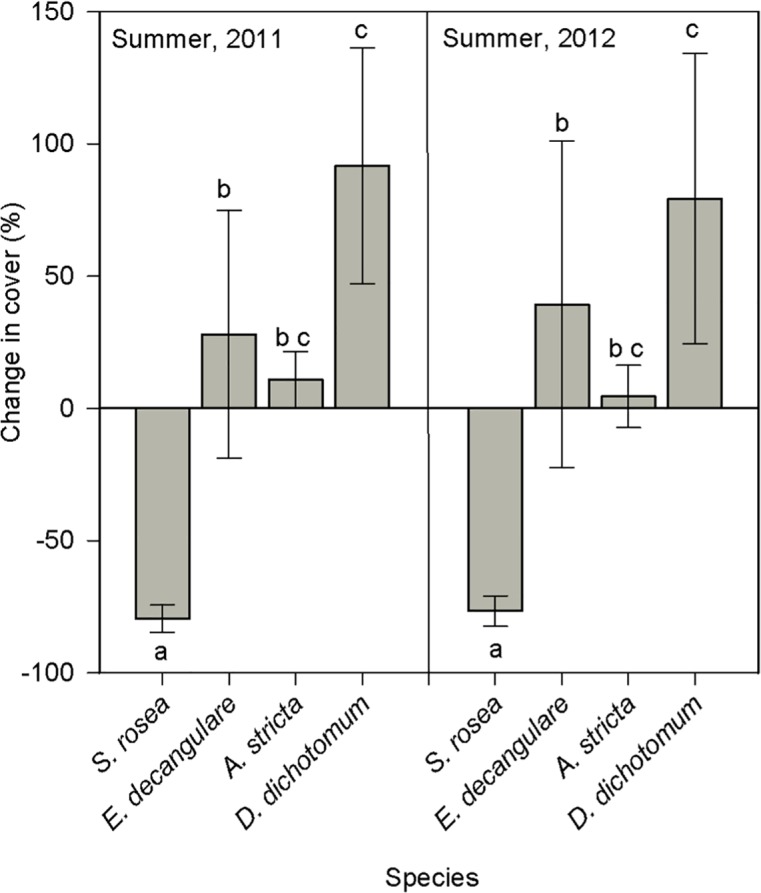
Percent cover change comparisons between Sarracenia rosea and three common species.Bar graph comparing percent change approximately one year and two years after treatment applications in 2010. Bars with the same letter are not significantly different (Tukey’s multiple mean comparison test).